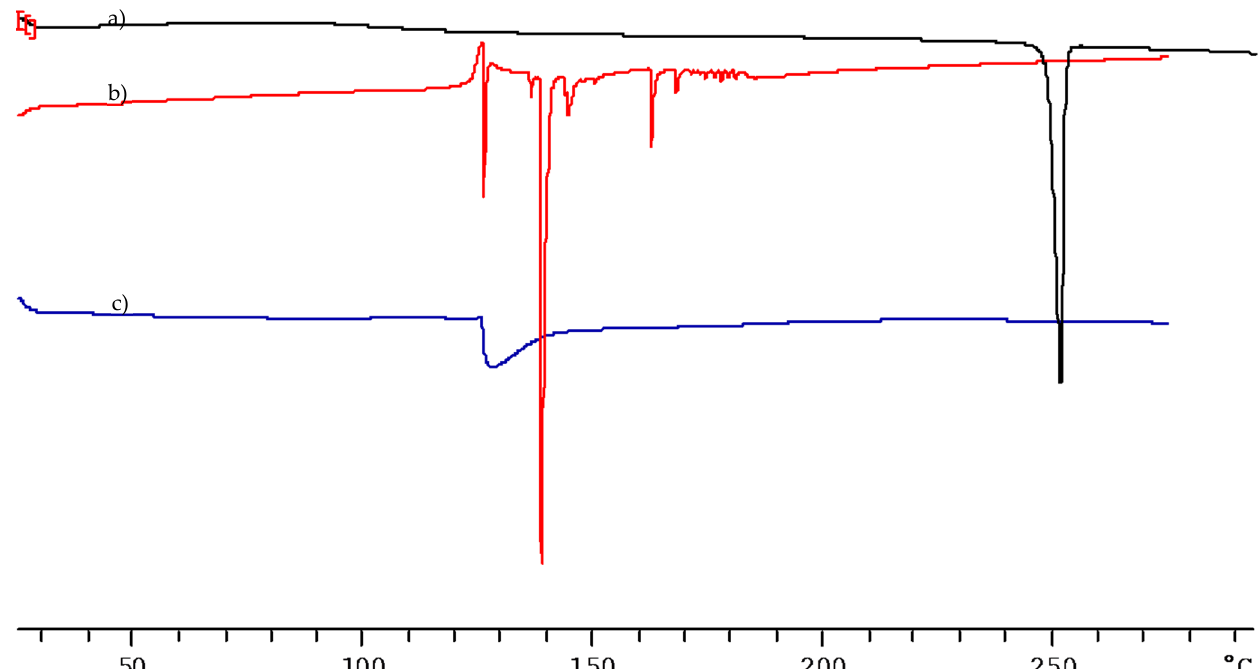
Materials 2021 , 14 , x FOR PEER REVIEW Figure 8 DSC thermograms of pure DA ( a ); pure AlgOX ( b ); and AlgOX-DA ( c ). Figure 8. DSC thermograms of pure DA ( a ); pure AlgOX ( b ); and AlgOX-DA ( c ).